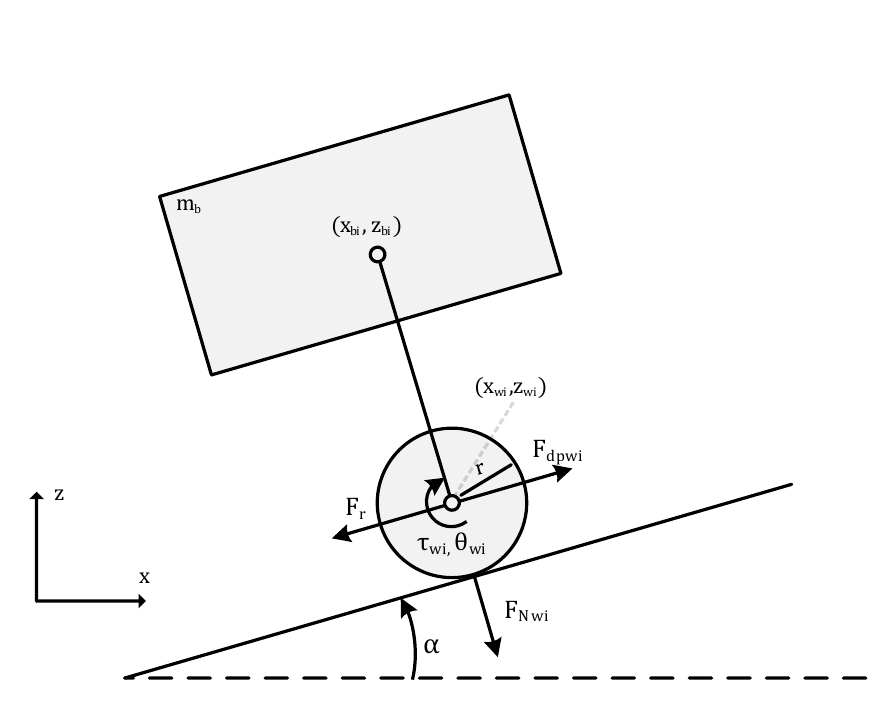
Figure 1. Diagram of the proposed normal driving model. Positions, forces and torques are depicted in order to illustrate the used notation and implied